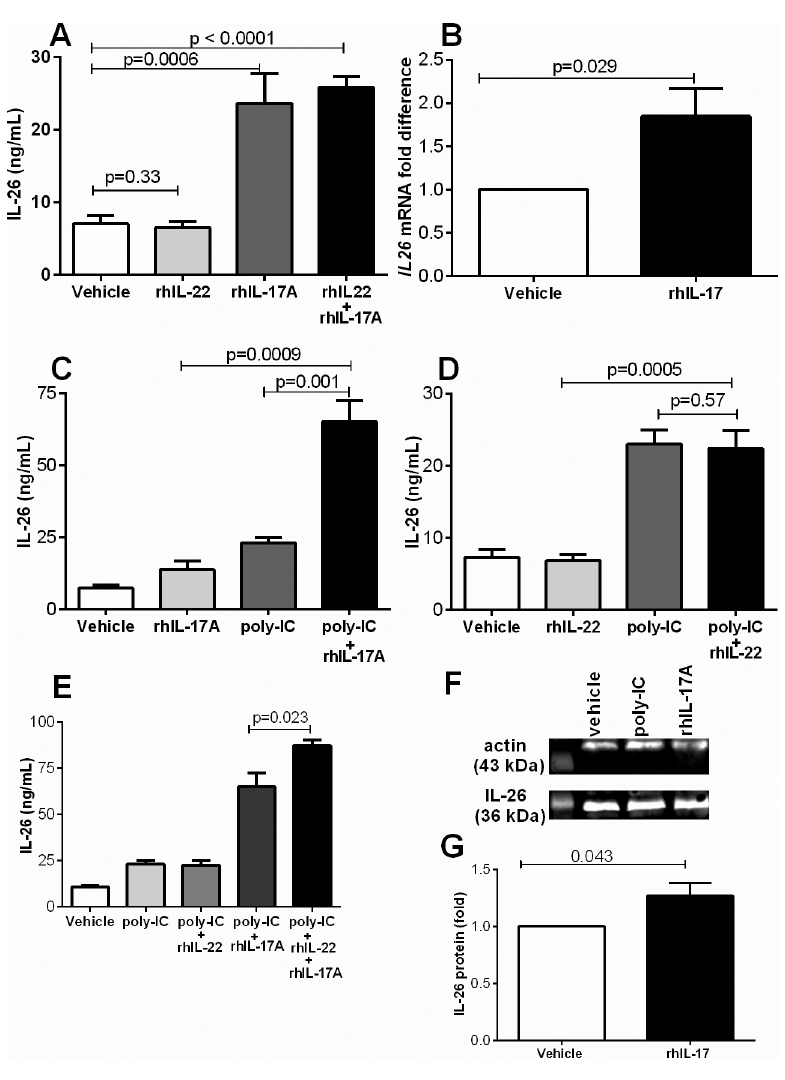
Figure 5. Th17 cytokines modulate poly-IC induced release of IL-26. Primary bronchial